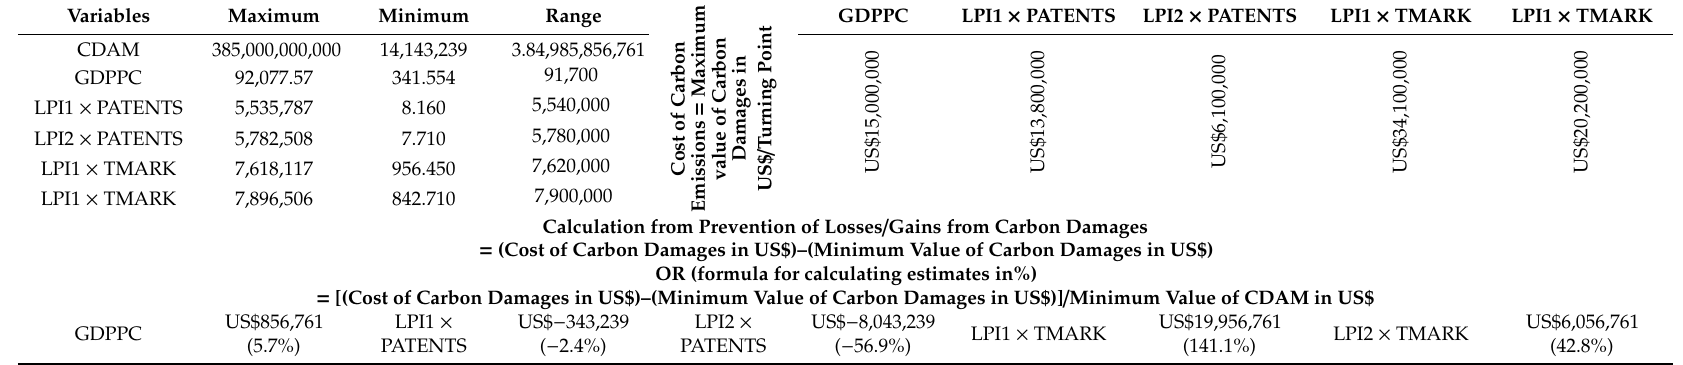
Table 6. Calculation of Carbon Damages with Technological –Induced Logistics Performance